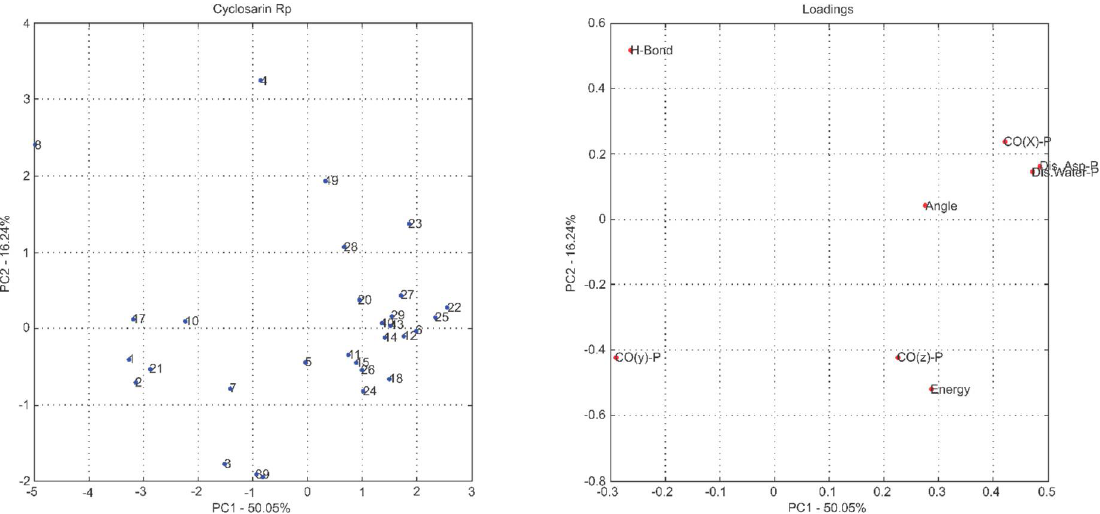
Figure 4. PC1 versus PC2 projection for Cyclosarin ( R P enantiomer) and loadings graph of the variables investigated ( left and right , respectively).